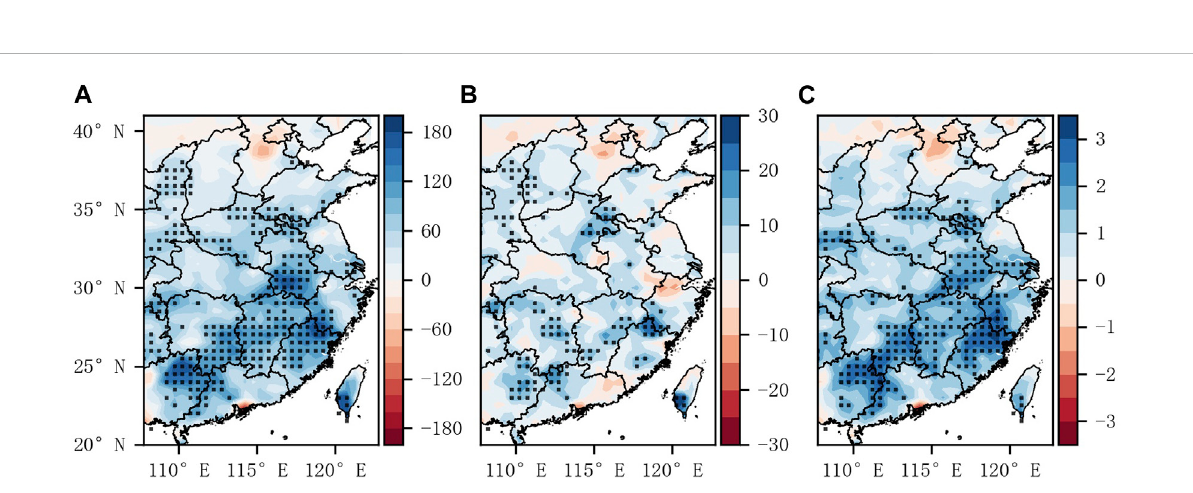
FIGURE 4 Interdecadal differences between P2 and P1 periods in eastern China (P2-P1): extreme precipitation amount (A) (units: mm); extreme precipitation intensity (B) (units: mm/d); extreme precipitation frequency (C) (units: d). Dotted areas indicate values exceeding the 95% con fi dence level by t